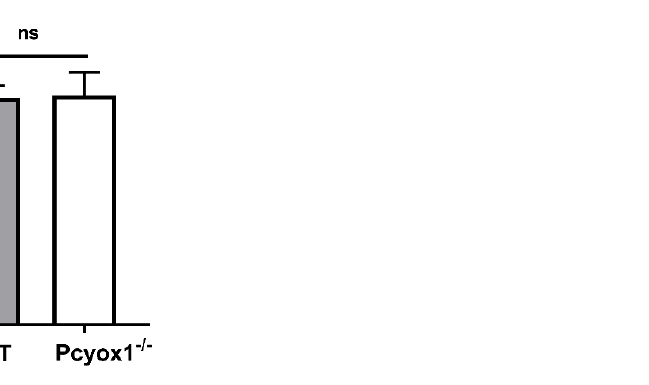
Figure 10. Fibrinogen levels in the WT and Pcyox1 −/− mice. Fibrinogen was detected by clauss meth- ods in plasma of WT and Pcyox1 −/− mice. n = 15 mice/group. Data are shown as mean ± SEM. Ns = not significance at Mann-Whitney U-test.